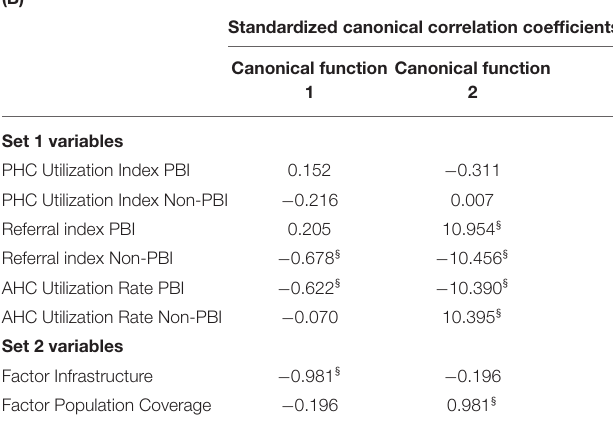
TABLE 2B | Standardized numbers were used for the canonic correlation analysis demonstrating multivariate correlation (Wilks’ test, p < 0.01).